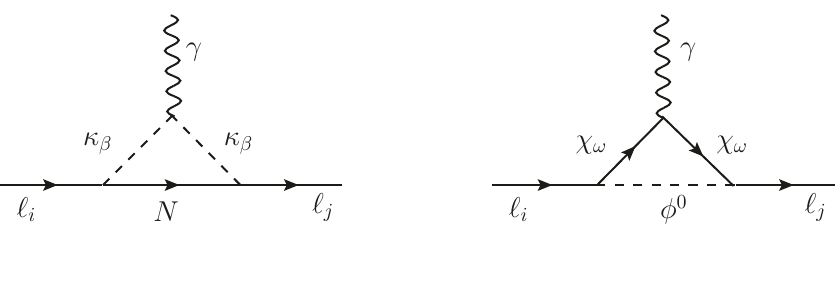
Figure 2 . One-loop diagrams leading to eEDM, anomalous muon MDM, and ‘ i ! ‘ j (cid:13) decays when i = j = 1, i = j = 2 and i 6 = j , respectively. Here (cid:30) 0 denotes the two Z 2 -odd neutral scalars A 0 and H 0